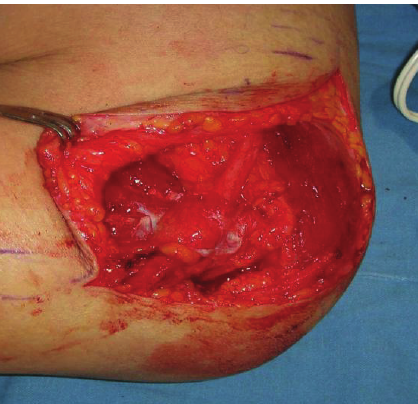
Figure 2: Wrapping procedure. Wrapping procedure was conducted by locating the ulnar nerve over the fascia and very loosely rolling the ulnar nerve with the elevated fascia flap. Closure could be tightly made together with the fascia.